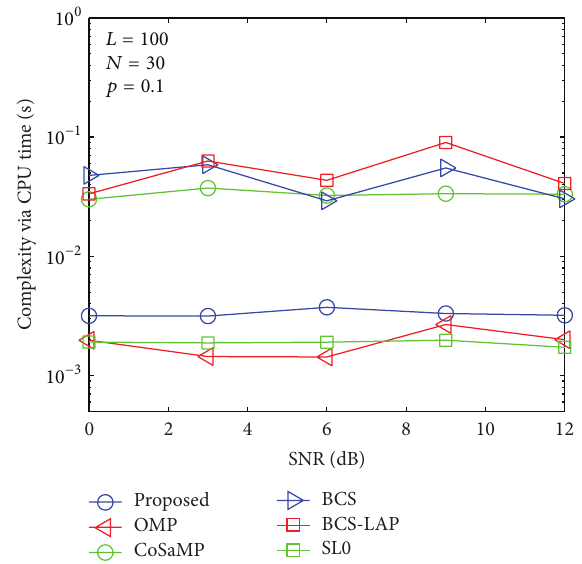
Figure 14: Computational complexity comparison via CPU time when 𝑝 1 = 0.1 and 𝑁 = 30 .